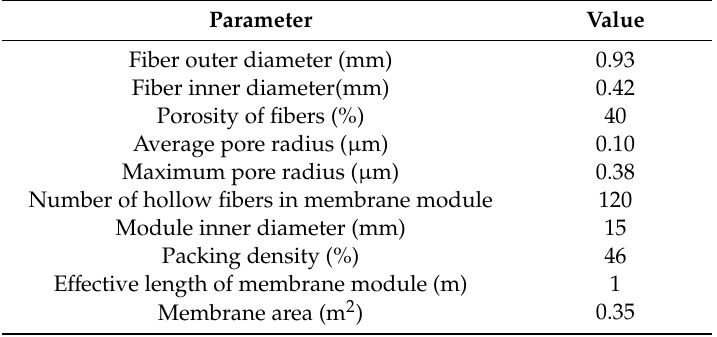
Table 1. Details of polytetrafluoroethylene (PTFE) hollow fibers and membrane